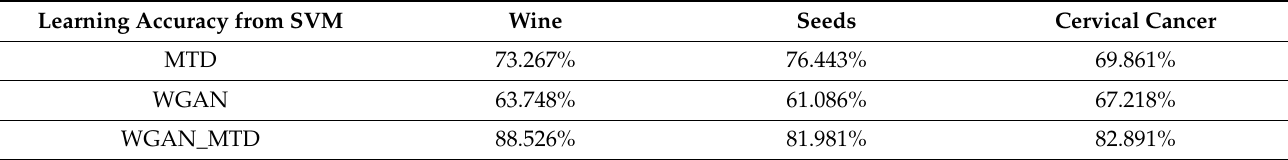
Table 6. The comparison of MTD, WGAN, and